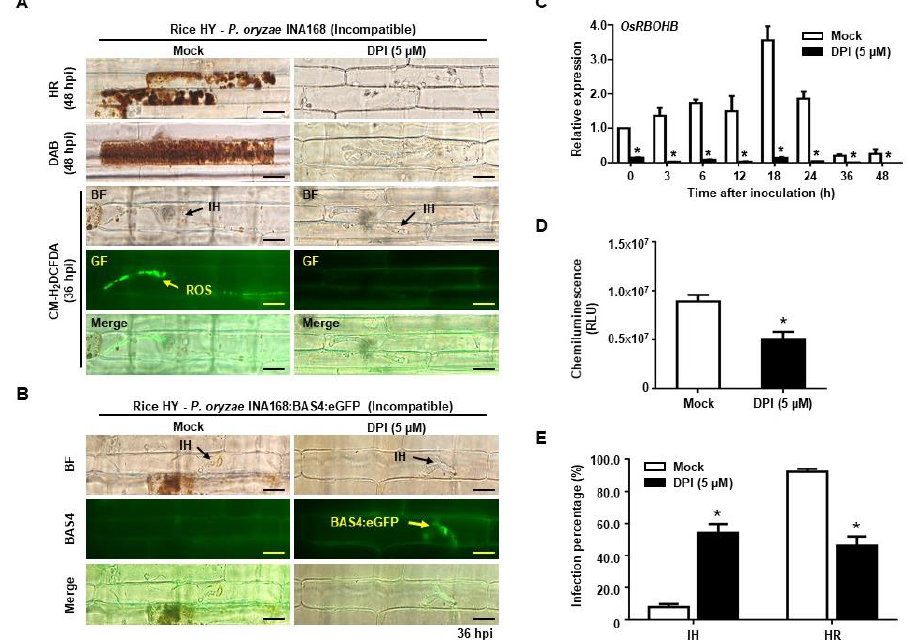
Figure 4. Inhibition of OsRBOHB by DPI treatment suppressed ROS accumulation and stimulated effector BAS4 expression during incompatible rice – P. oryzae interactions. ( A ) DPI treatment suppressed ROS accumulation in rice cv. HY cells inoculated with P. oryzae INA168. DAB and CM-H 2